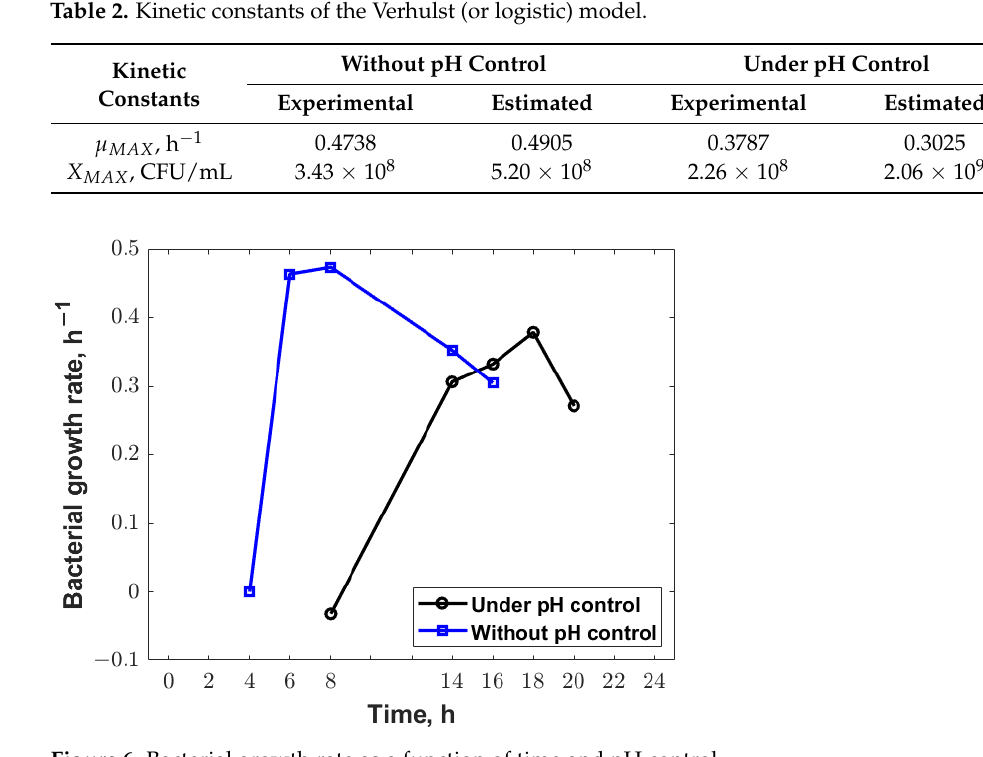
Figure 6. Bacterial growth rate as a function of time and pH control.